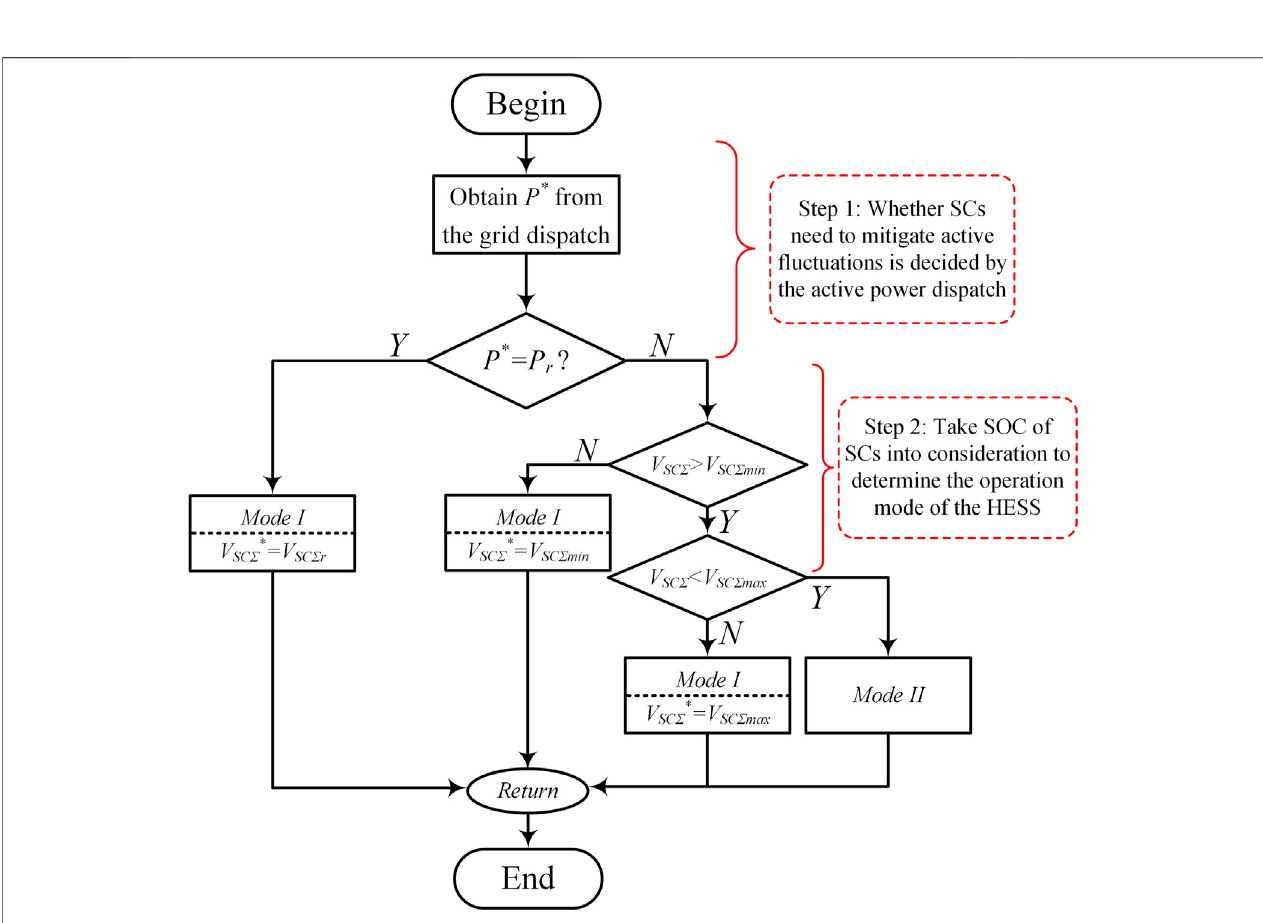
FIGURE 3 | Flowchart of operation mode switching